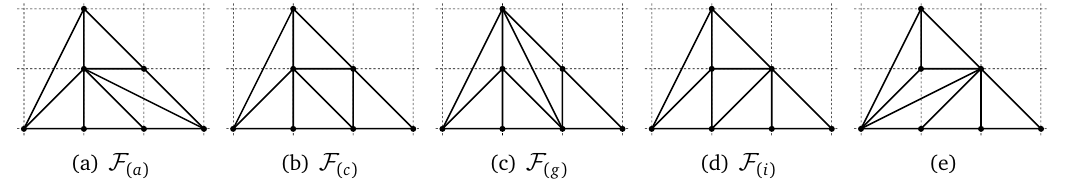
( 0, T ) 2 toric diagram. For the first 4 of them, 3 = 2 field-theory prepotentials they correspond to, as we f